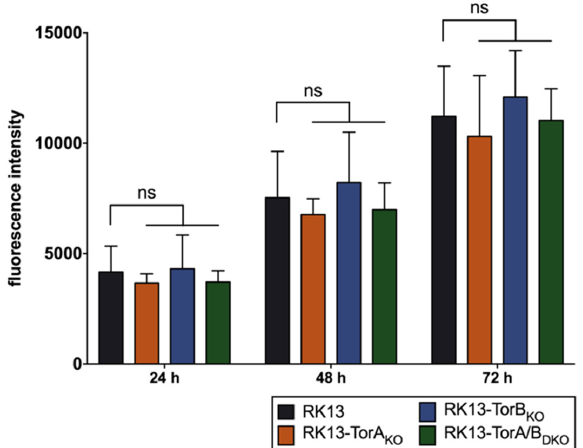
Figure 7. Cell viability of generated modified cell lines. RK13 control together with Torsin KO cell lines were seeded with 1 × 10 4 cells per well and at 24, 48, and 72 h post seeding the mitochondrial activity was measured (in fluorescence intensities) with the Presto Blue Assay. Shown is the mean of three independent experiments, ns = statistically not significant.